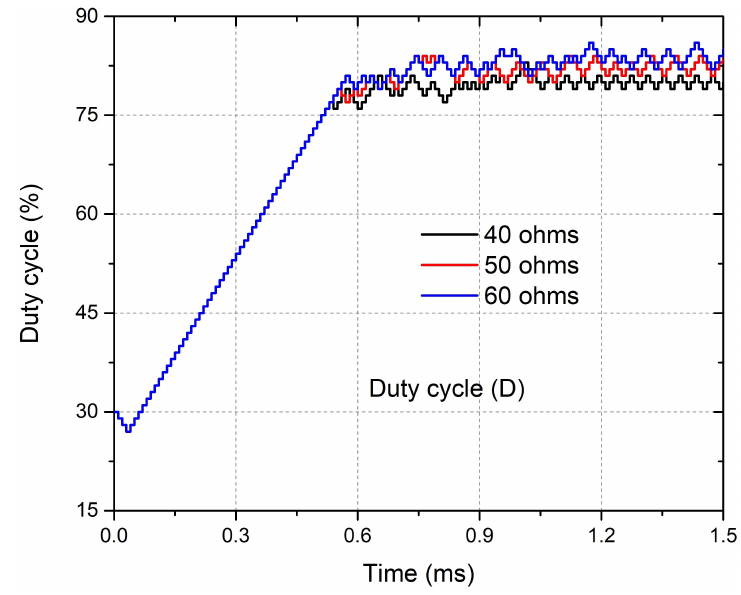
Figure 18. Duty cycle plot obtained using P&O